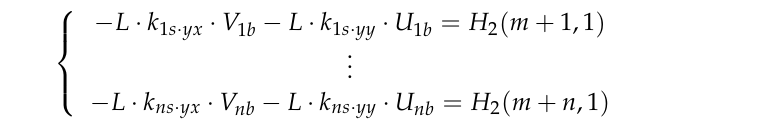
Figure 1. Multi-disc and multi-span rotor-bearing system. According to Equation (1), Equation (6) can be